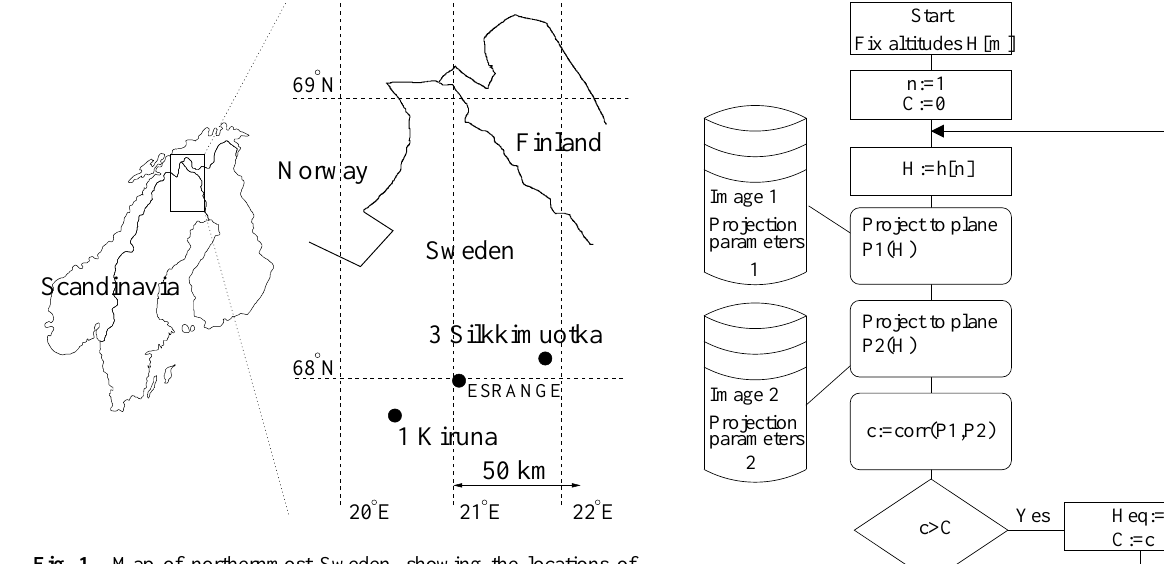
Fig. 1. Map of northernmost Sweden, showing the locations of ALIS station 1 (Kiruna, 67 ◦ 50 0 27 00 N, 20 ◦ 24 0 40 00 E), ALIS station 3 (Silkkimuotka, 68 ◦ 1 0 47 00 N, 21 ◦ 41 0 13 00 E), and ESRANGE.